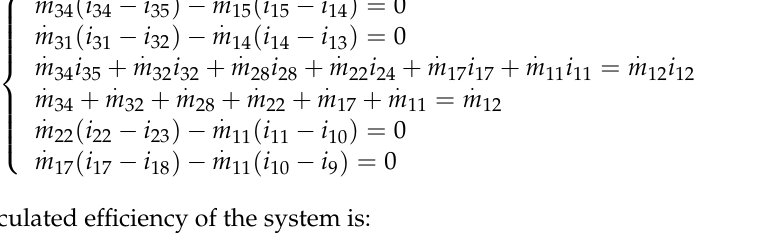
Figure 11. A thermal flow diagram of a complex regenerative cycle. Table 6. Thermodynamic parameters of the working fluid in the control planes of a complex re- generative cycle.